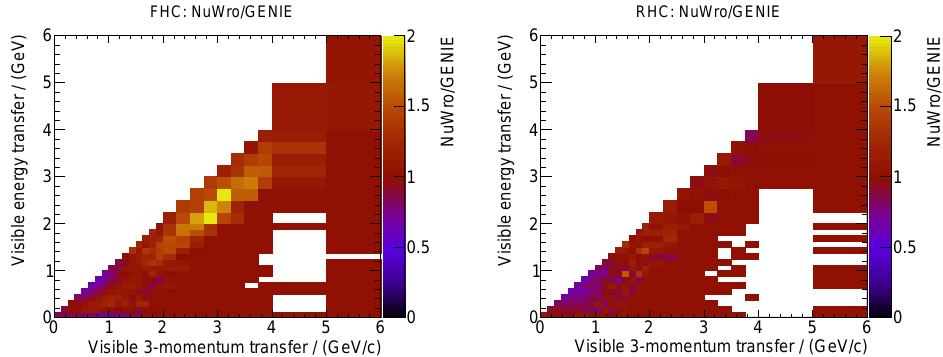
Figure 70. ( Left ): Ratio of NuWro-reweighted HPgTPC ν µ (FHC) sample to GENIE sample for all reconstructed events. ( Right ): Ratio of NuWro-reweighted HPgTPC ν µ (FHC) sample to GENIE sample for all reconstructed events. Bins with <100 true MC events are not